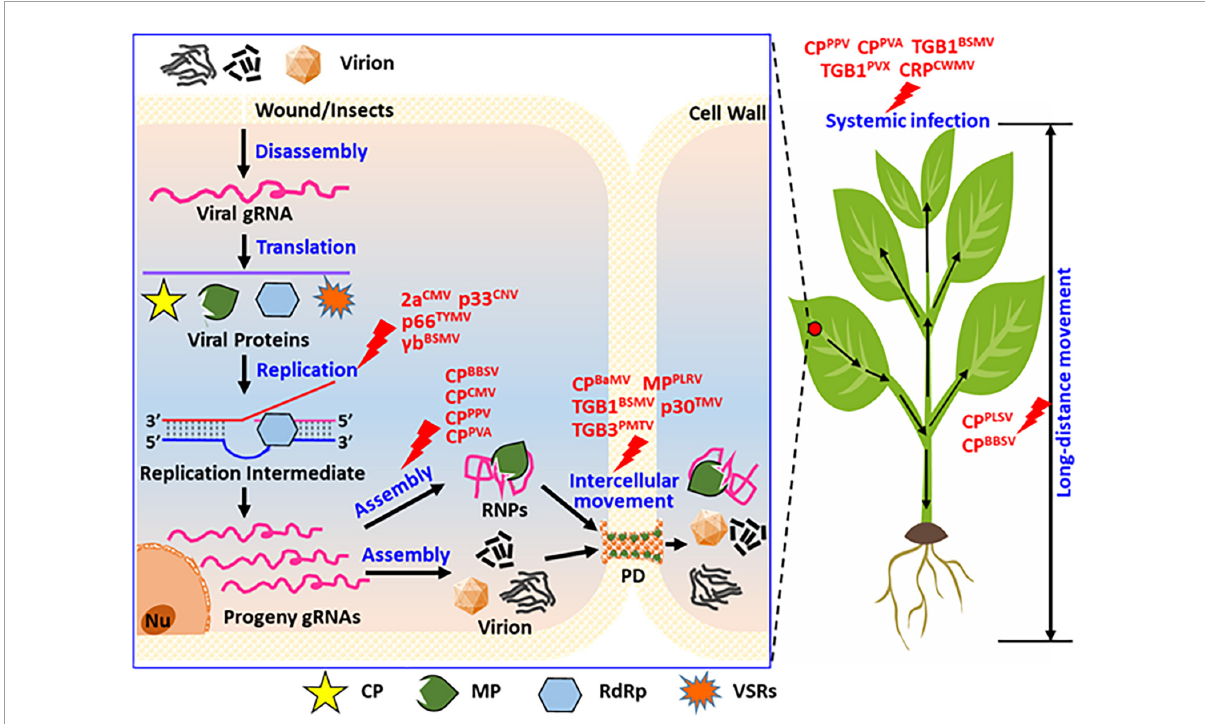
FIGURE3 Summary of the functions of phosphorylated proteins encoded by positive single-strand RNA viruses during their life cycle. In view of the entire cell and whole plants, viral protein phosphorylation affects the replication, virion assembly, intracellular movement, long-distance movement, and systemic infection of the plants. As displayed, phosphorylation modification affected virus replication, for instance, the replicase of CMV (2a), CNV (p33), TYMV (p66), and the suppressor of BSMV ( γ b), these proteins not all are replicase, also contains virus-encoded RNA silencing suppressor. Phosphorylation modification of CP affected virion assemblies, such as the coat protein of BBSV, CMV, PPV, and PVA. Phosphorylation modification of viral proteins affected virus intercellular movement, such as movement protein of PLRV (MP), BSMV (TGB1), TMV (p30), PMTV (TGB3), also contains the coat protein of BaMV (CP). Phosphorylation modification of viral proteins affected virus long-distance movement, such as coat protein of PLSV (CP PLSV ) and BBSV (CP BBSV ). Phosphorylation modification of viral proteins affected virus systemic infection of host plant, such as coat protein of PPV (CP PPV ), PVA (CP PVA ), and movement protein of BSMV (TGB1 BSMV ), PVX (TGB1 PVX ), and the cysteine-rich protein of CWMV (CRP CWMV ). These viruses display rod-shaped, filamentous, and spherical particles under